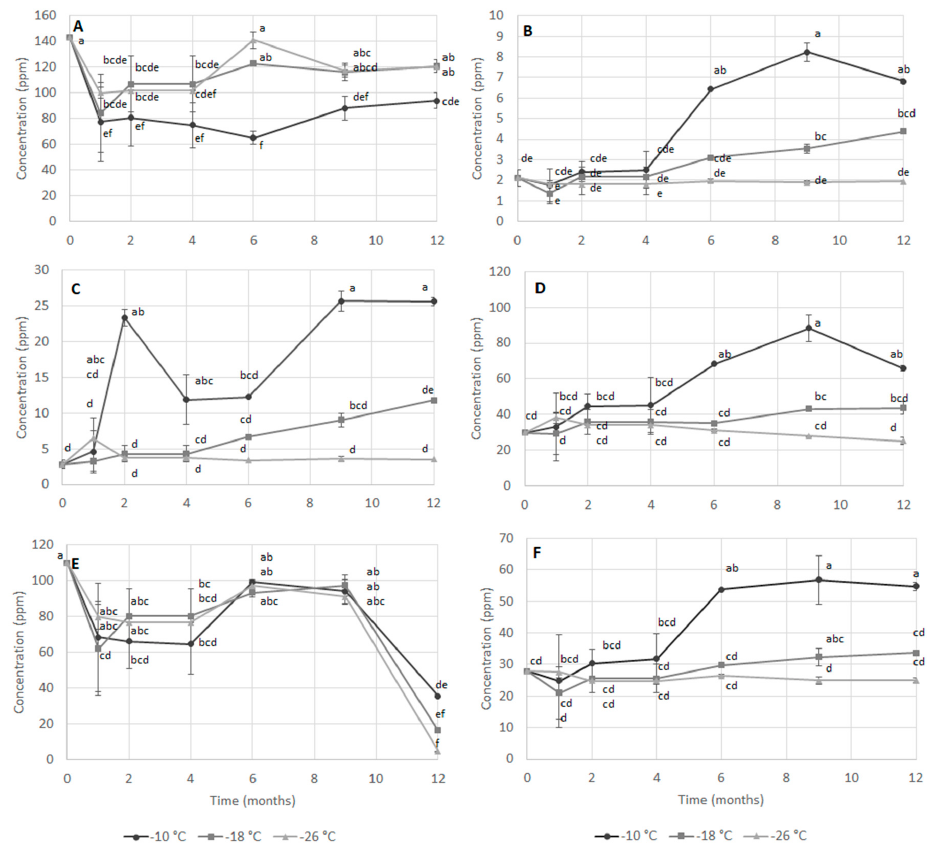
Figure 3. Concentration (ppm) of trimethylamine-O (TMA-O) ( A ), trimethylamine (TMA) ( B ), dimethylamine (DMA) ( C ), lysine ( D ), sarcosine ( E ) and alanine ( F ) measured by 1 HR-NMR in extracts of mantis shrimp mechanically separated flesh during frozen storage at − 10, − 18 and − 26 ◦ C. Di ff erent letters indicate significant differences (at p < 0.05) among samples. Table 4. F (Fisher) values and relative significance of the influence of storage time (St) and temperature (T) and their interaction (St T) on quality parameters of mechanically separated mantis flesh, evaluated by 1 HR-NMR. Factor